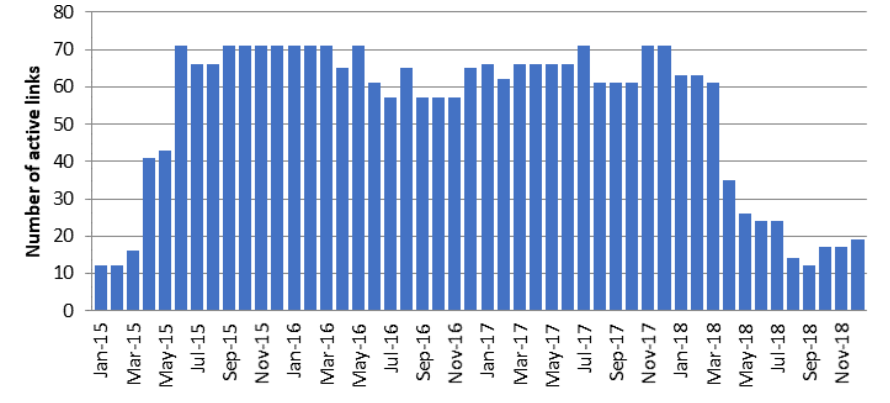
Figure 7: Number of active links in the area of Bielsko-Biala